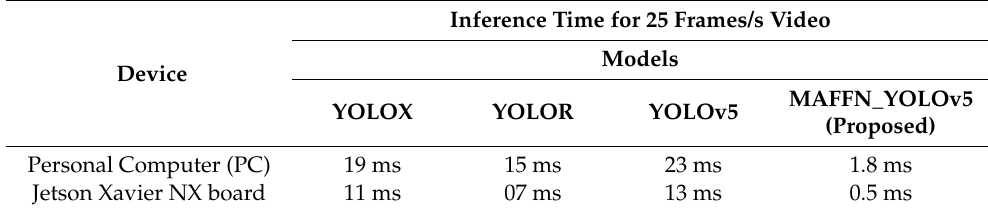
Table 5. Execution time comparison of the Jetson Xavier NX-based health detection